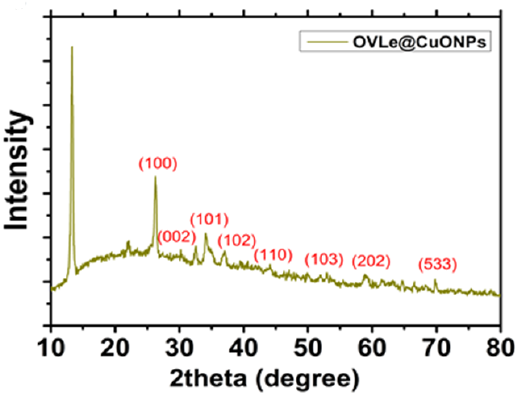
Figure 4. XRD of CuO @OVLe NCs.